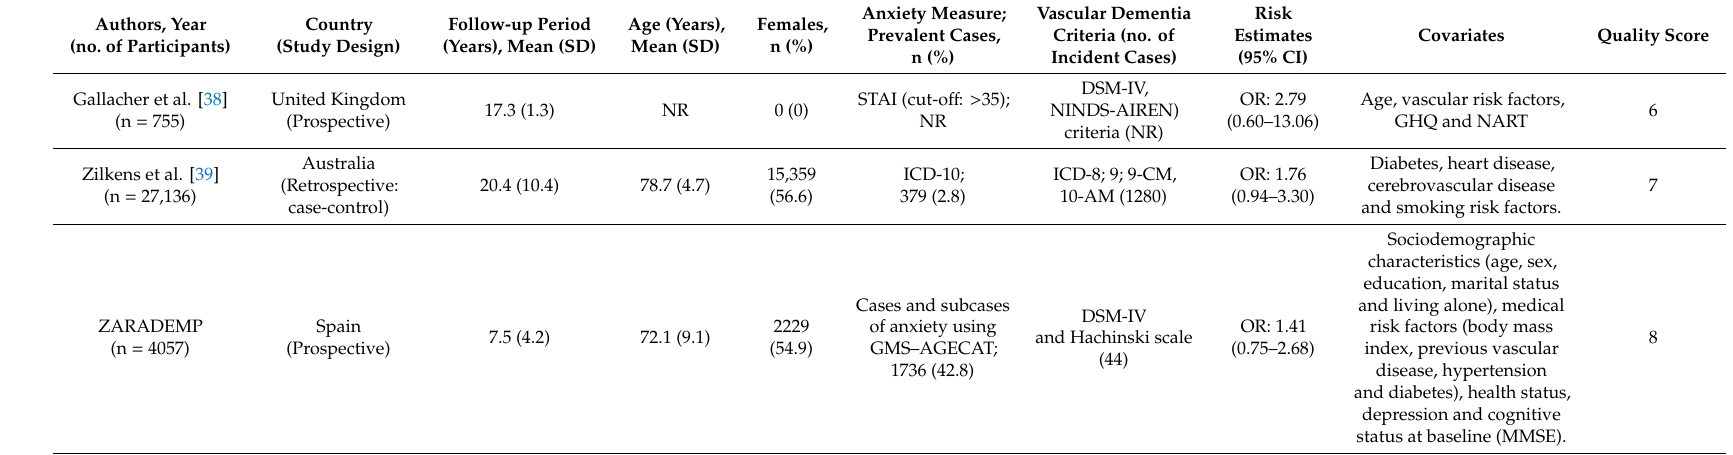
Table 3. Characteristics of included